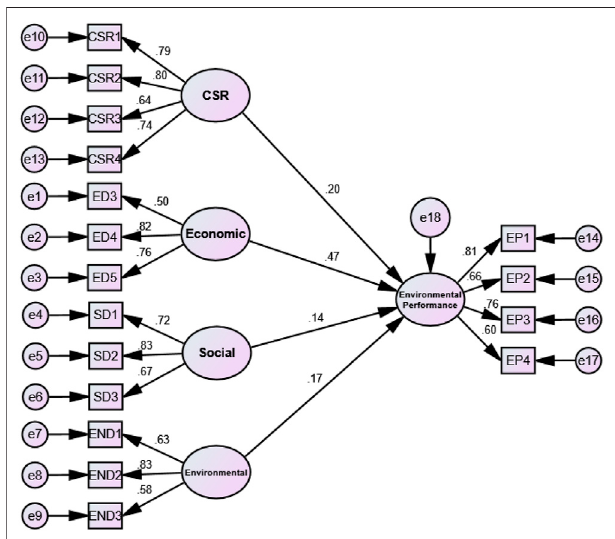
FIGURE 4 | Structural model with standardized